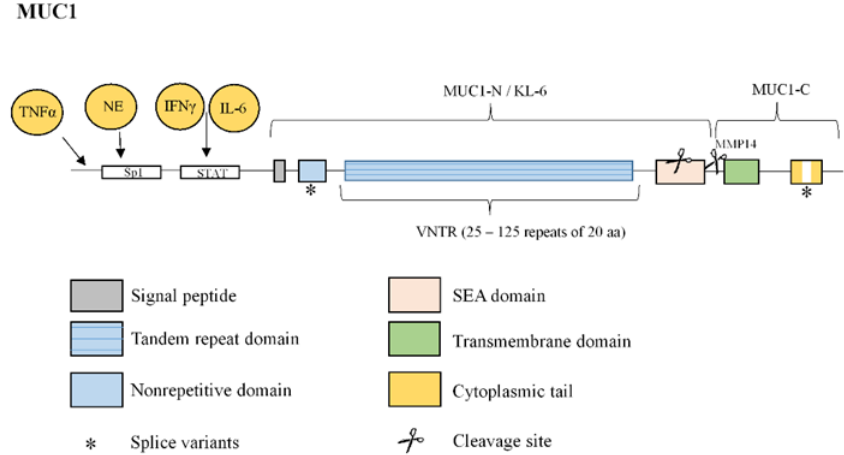
Figure 6. Structure of mucin MUC1. MUC1 protein is comprised of an N-terminal subunit (also called KL-6) constituted by an extracellular variable number tandem repeat (VNTR) domain composed of 25–125 repeats of 20 amino acids, and a C-terminal subunit constituted by a SEA domain, a transmembrane domain and a cytoplasmic tail (CT). MUC1 extracellular domain can be shed into the lumen by proteolytic cleavage in the SEA domain or by the action of metalloproteinase 14 (MMP14) in the region following the SEA domain. Two examples of splice variants of MUC1 transcript are shown (*): a nonrepetitive sequence insertion prior to the variable number tandem repeat (VNTR) region and variations in the CT. MUC1 overexpression is induced by activation of the single STAT-binding site of MUC1 promoter by interferon (IFN) γ or interleukin (IL)-6 or by an increased Sp1 binding to MUC1 promoter by neutrophil elastase (NE). Tumour necrosis factor α (TNF α ) also upregulates the transcription of MUC1.